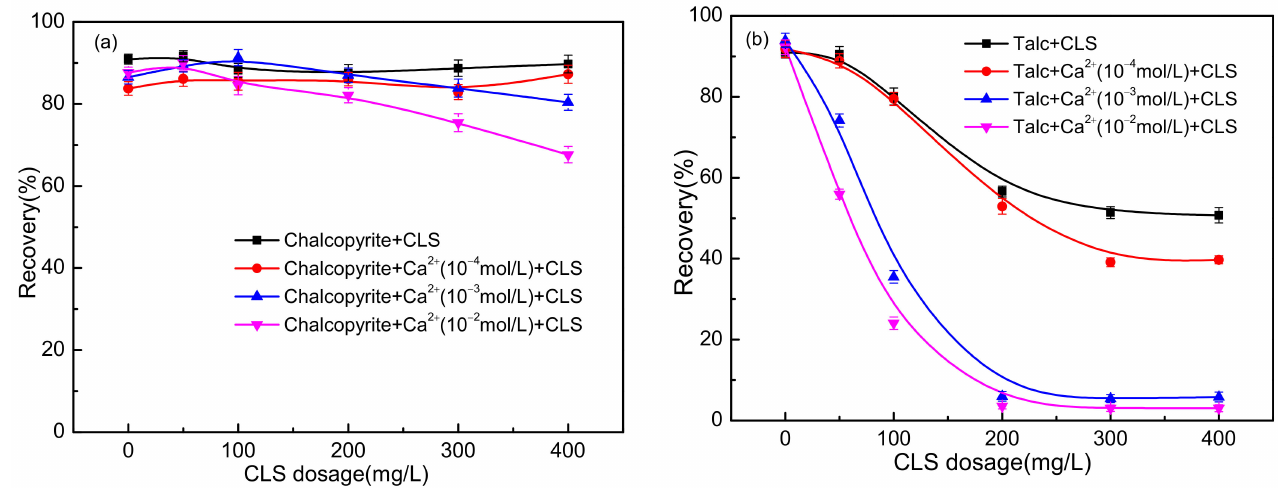
Figure 5. Effects of CLS dosage on the flotation behavior of chalcopyrite ( a ) and talc ( b ) in the presence of various Ca 2+ ions (c(PBX) = 50 mg/L, c(MIBC)= 0.125 mL/L, pH = 8).